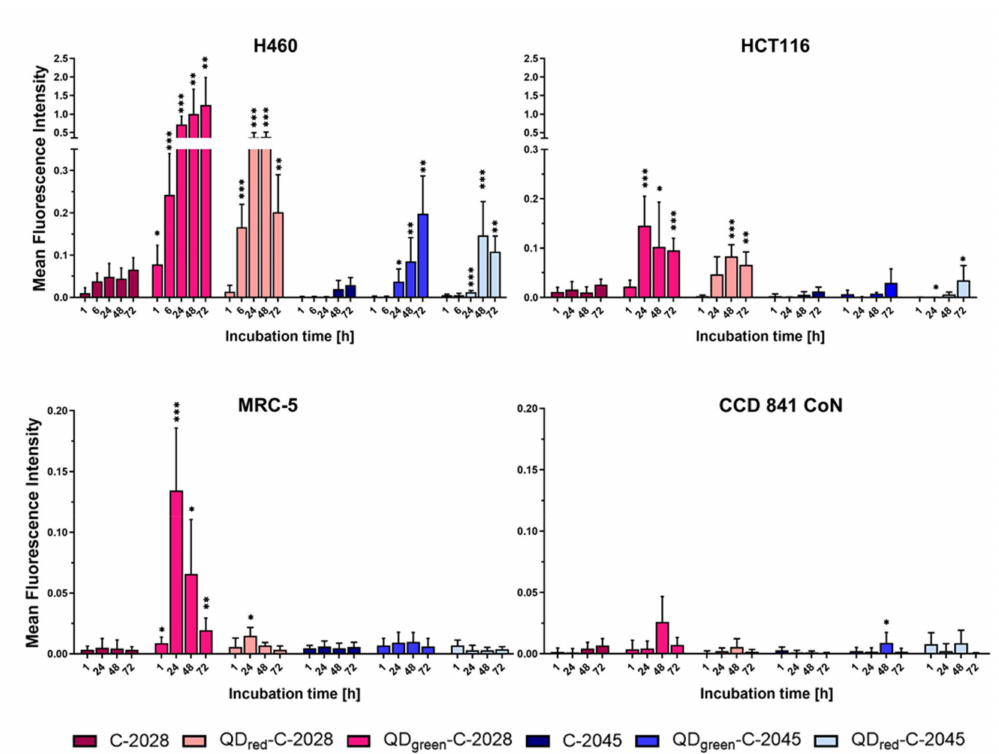
Figure 3. Cellular uptake of UAs, and QD − UA hybrids to cancer (H460 and HCT116) and normal (MRC-5 and CCD 841 CoN) cells for the time indicated and analyzed by Confocal Laser Scanning Microscope (CLSM). Mean Fluorescence Intensity (MFI) values of UAs and QDs − UAs were determined using ImageJ software. Data are expressed as the mean ± standard deviation of three independent experiments. * p < 0.05, ** p < 0.01, *** p < 0.001—statistically significant differences between the MFI of UAs in the cells incubated with UAs alone and QD − UA hybrids (Student’s t